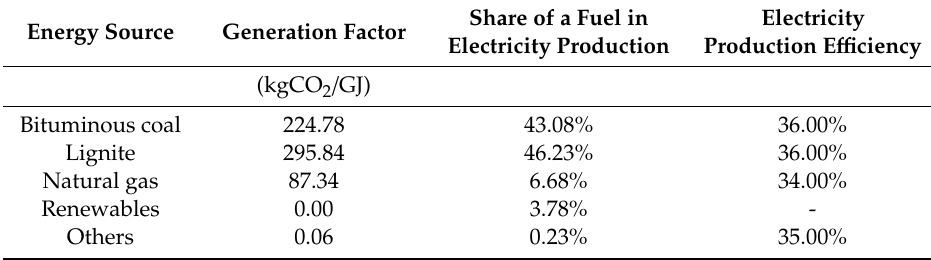
Table 5. Ciura [34] estimated the low voltage electricity transfer e ffi ciency at 79.2% Table 5. The shares of the energy sources in electricity production in Poland